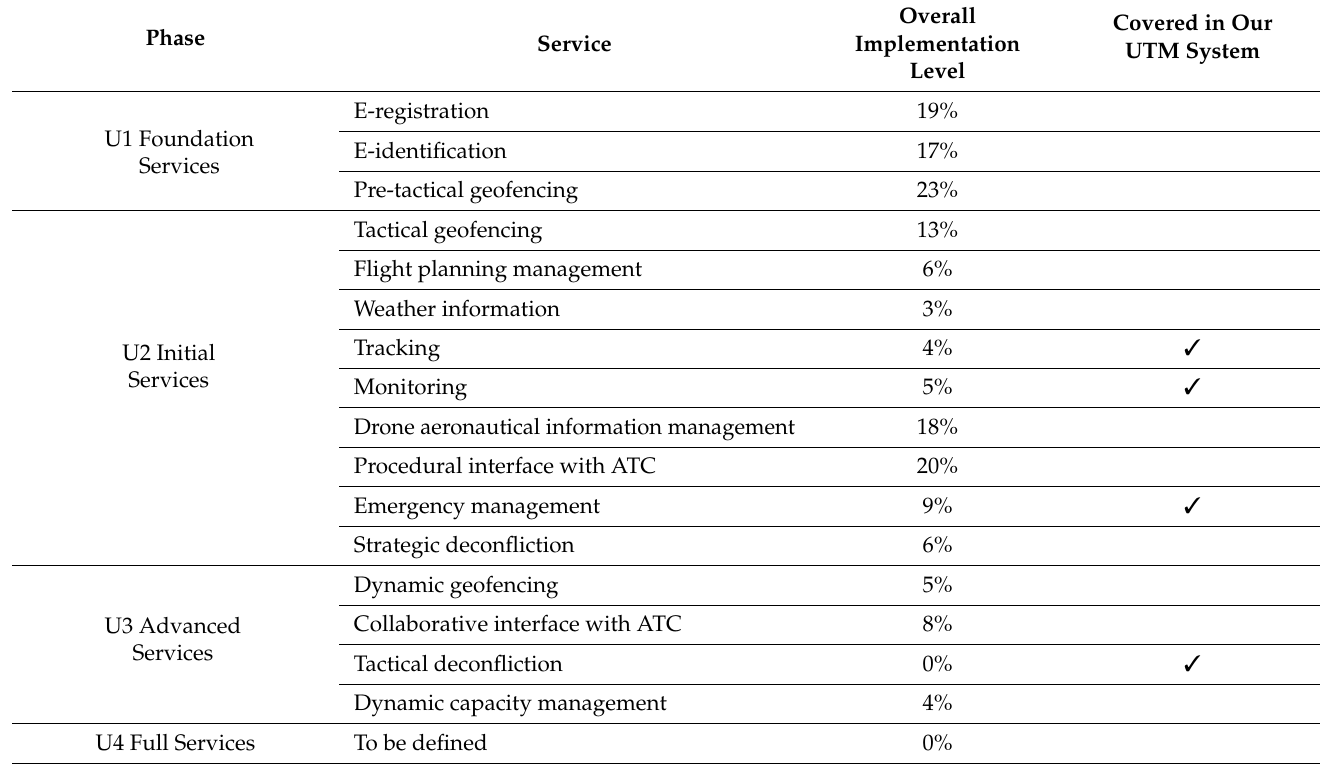
Table 1. The U-space services for each development phase, together with their current implementation level. Our system focuses on in-flight services to handle unexpected events during the flight phase of the UAS. Phase Service